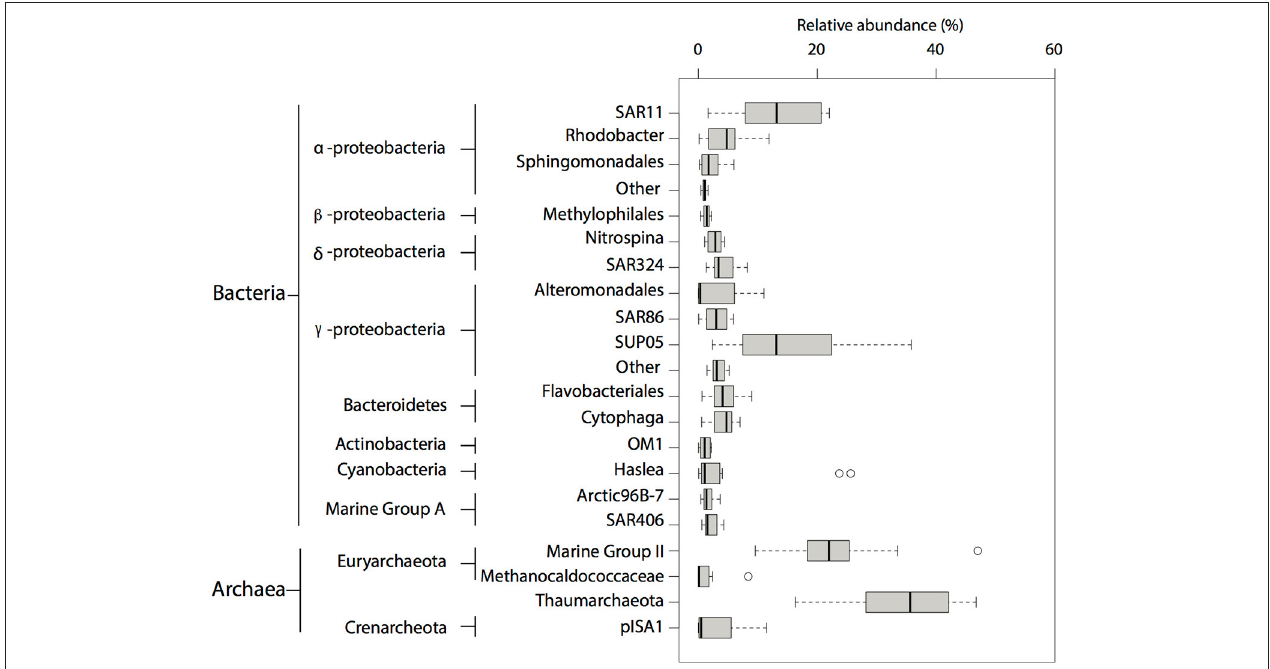
FIGURE 2 | Taxonomic composition of OTUs identified in SSU rRNA gene pyrotags between 2008 and 2010. Abundant ( > 1% relative abundance) taxa found in pyrotag dataset. The size of each box represents the average of relative abundance ( > 0.01%) calculated from the total number of prokaryotic reads throughout the water column over this period. Extended dashed lines (whiskers) represent at the base the lower and upper quartiles (25 and 75%) and at the end the minimum and maximum values encountered. The middle line represents the